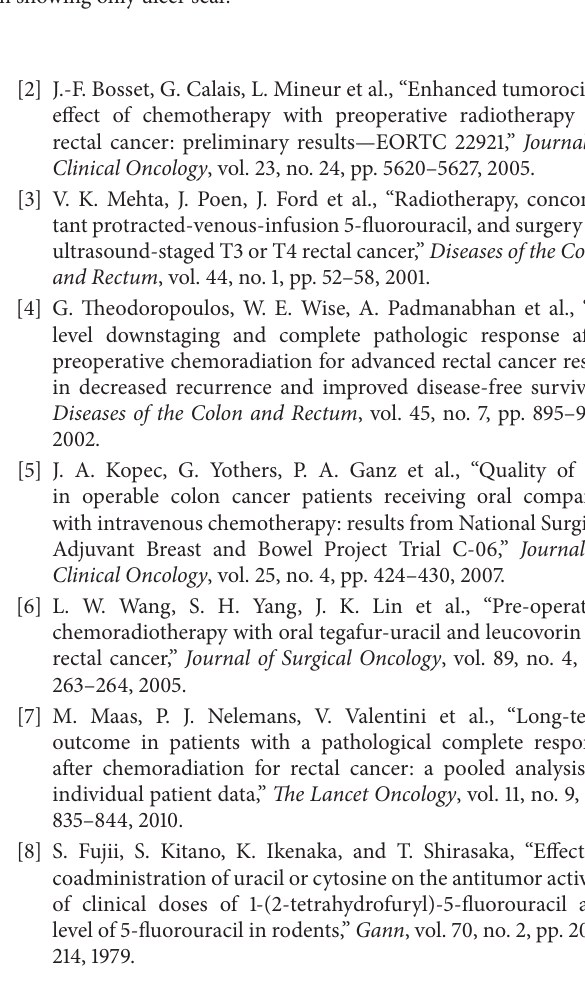
Figure 3: Resected specimen showing only ulcer scar.